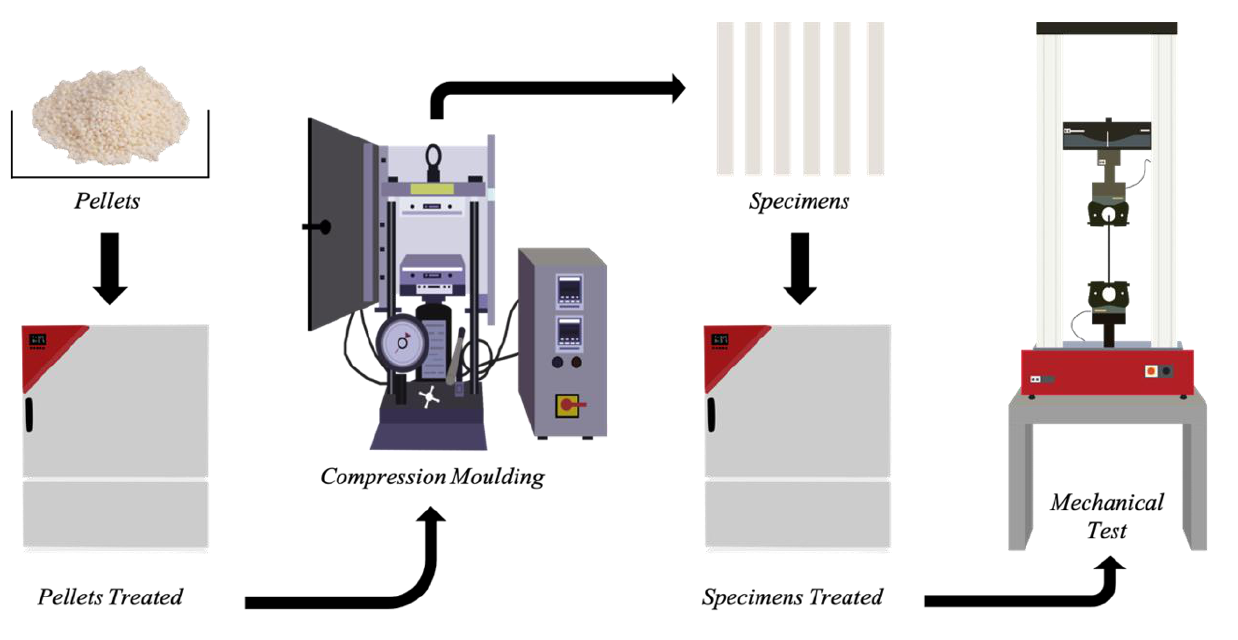
Figure 1. Scheme of the procedure adopted in this work.